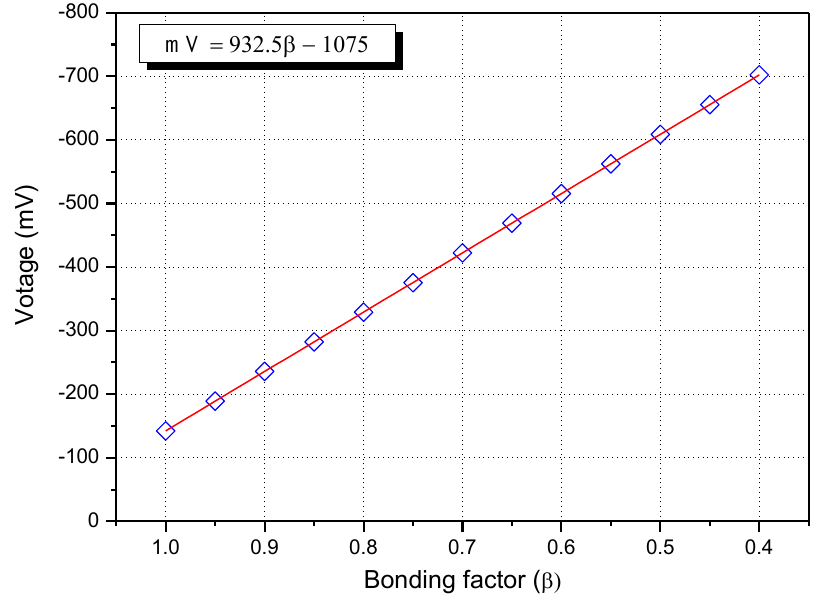
Figure 20. Relationship between bonding factor ( β ) and average potential difference in terms of voltage (mV) of flexural beam specimens.